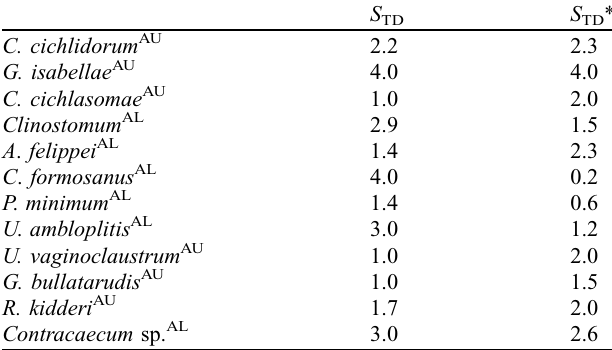
Table 3. Values of Poulin and Mouillot’s [26, 27] indices of host specificity, S TD and S TD * for six species of adult autogenic helminths (marked as AU) and six allogenic larval (AL) parasites of 11 freshwater fishes of Apazapan, Río La Antigua, Veracruz, Mexico (note that for all other 18 adult autogenic helminth species having only one host, S TD = 1, and S TD * =